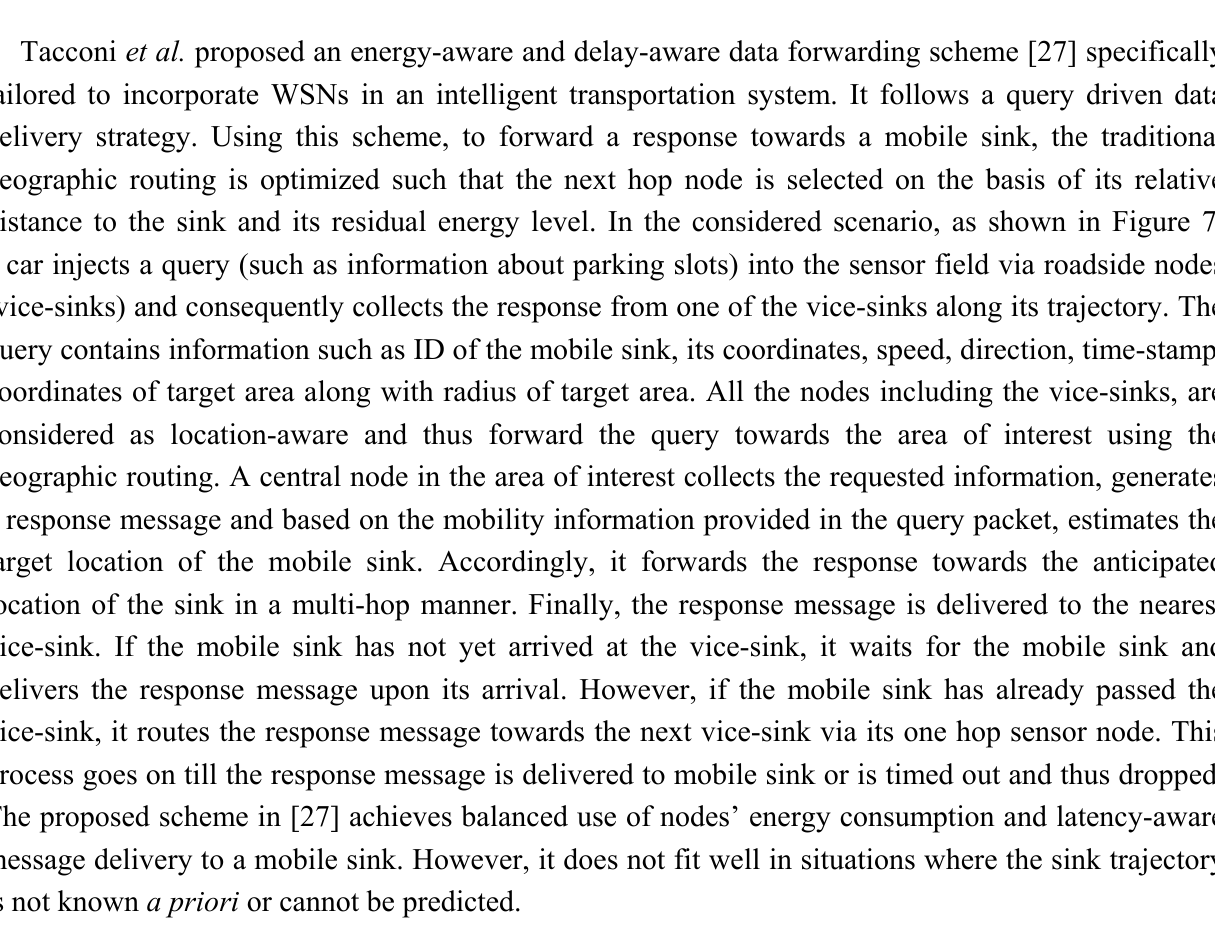
Figure 7. System architecture: A mobile sink (MS) queries network via vice-sinks (VSs). Sensor nodes (SNs) inside network communicate in multi-hop fashion to reach to VSs